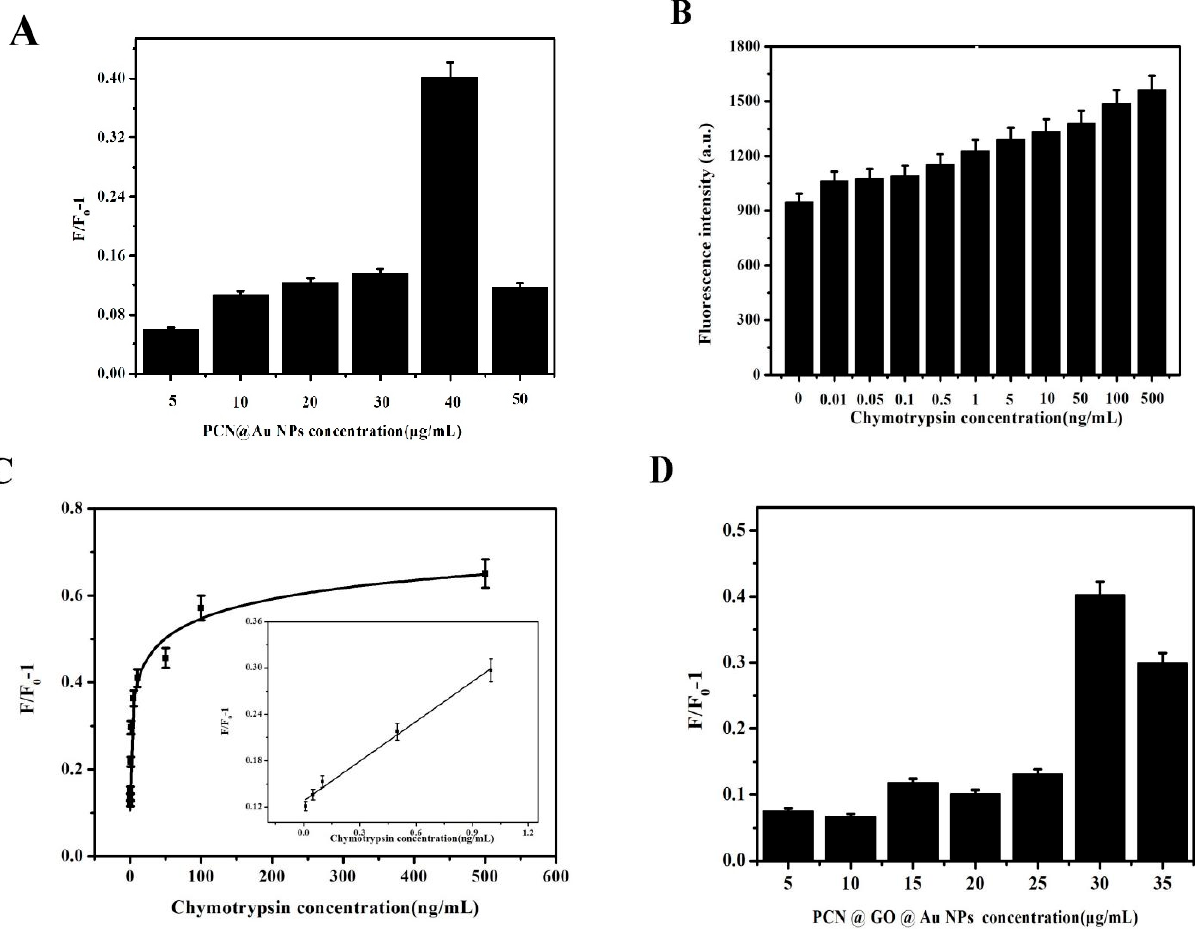
Figure 3. ( A ) The fluorescence intensity caused by different concentrations of PCN@AuNPs. ( B , C ) Detection of different concentrations of chymotrypsin using Cu NC-P sensors. ( D ) The fluorescence intensity with different concentrations of PCN@GO@AuNP composite nanomaterials. (The sample number was 5).